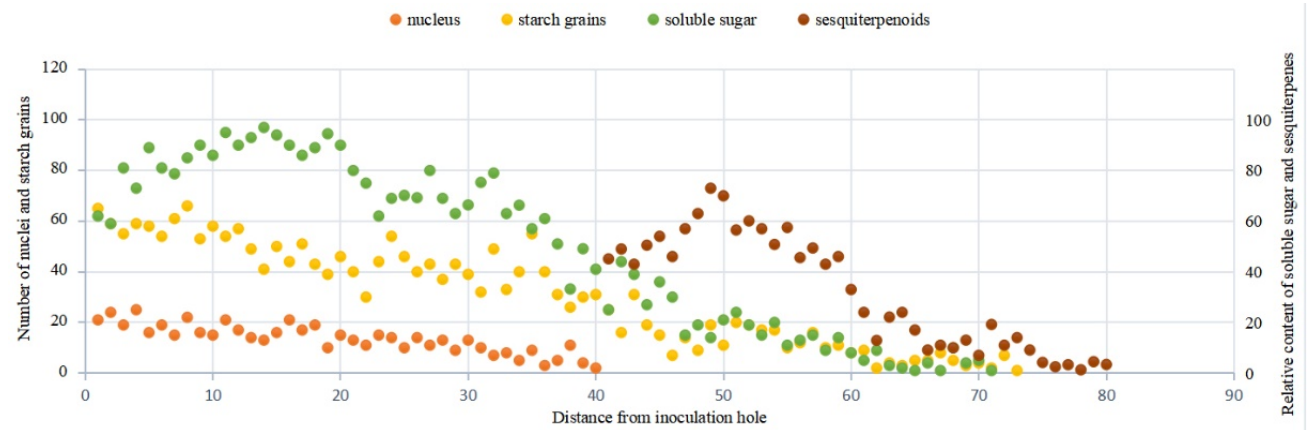
Figure 15. Trends of various indicators in xylem of agarwood-bearing A. sinensis .